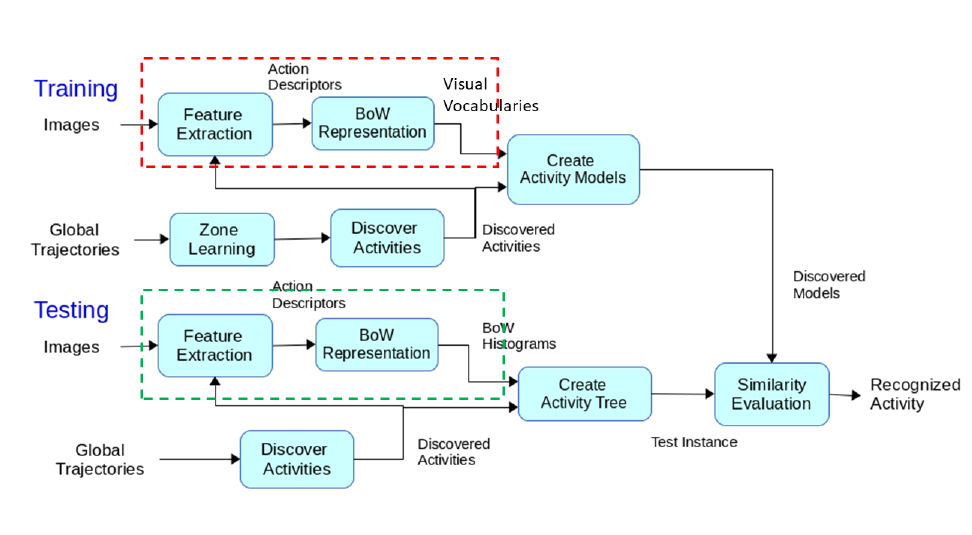
Figure 1. The flow diagram of the unsupervised framework: Training and Testing phases. The red dashed box shows the training of the visual codebooks of the descriptors. The green box in the testing phase shows the descriptor matching